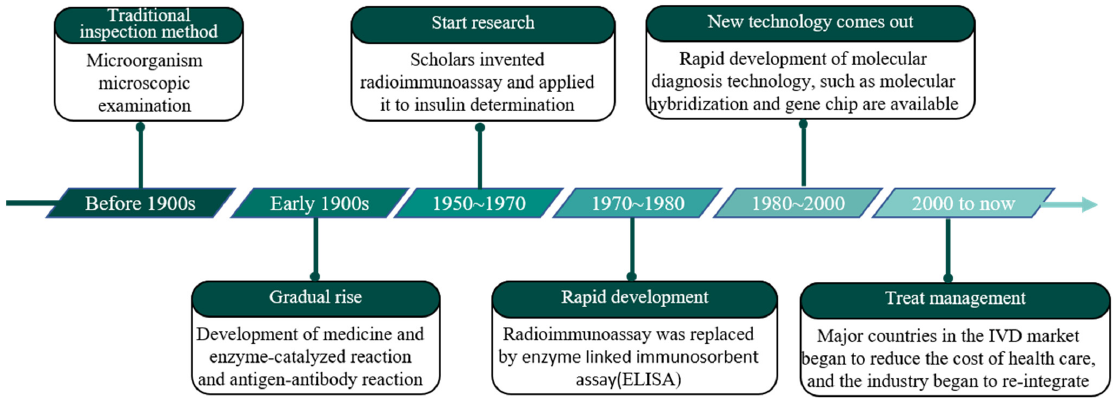
Figure 1. Historical development diagram of in vitro diagnostic industry.